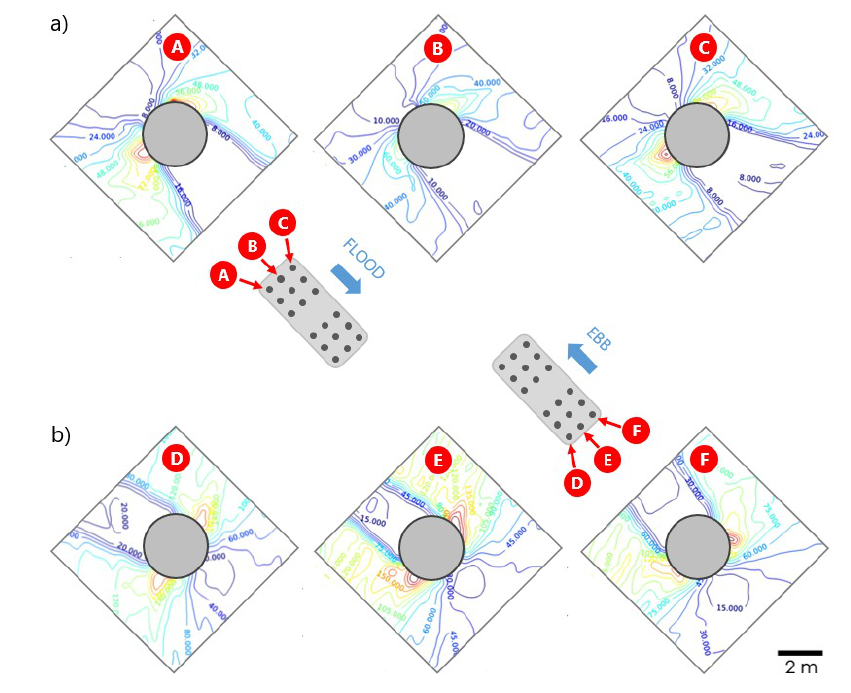
Figure 8. Iso-contours plots of shear stress τ (measured in Pa) around the piles of North Tower for ( a ) flood-tide and ( b ) ebb-tide scenarios. High intensity shear stress is shown in yellow, and low intensity in blue. For simplicity, only results for the front and rear rows of the tower were shown. Figures adapted from [29].